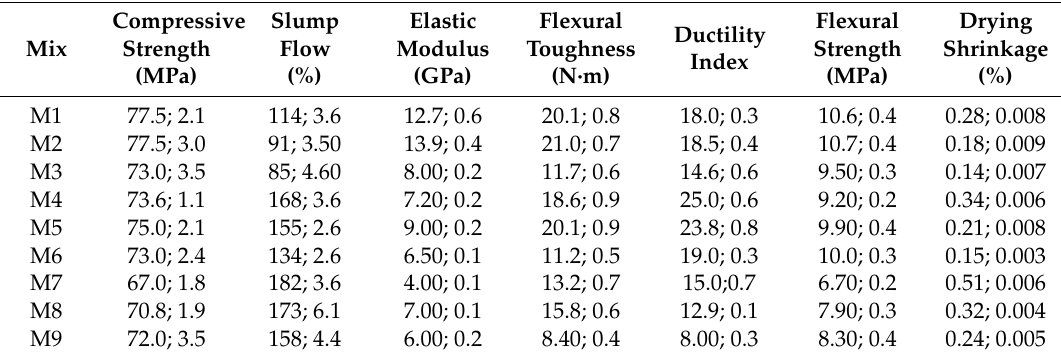
Table 7. Experimental results.